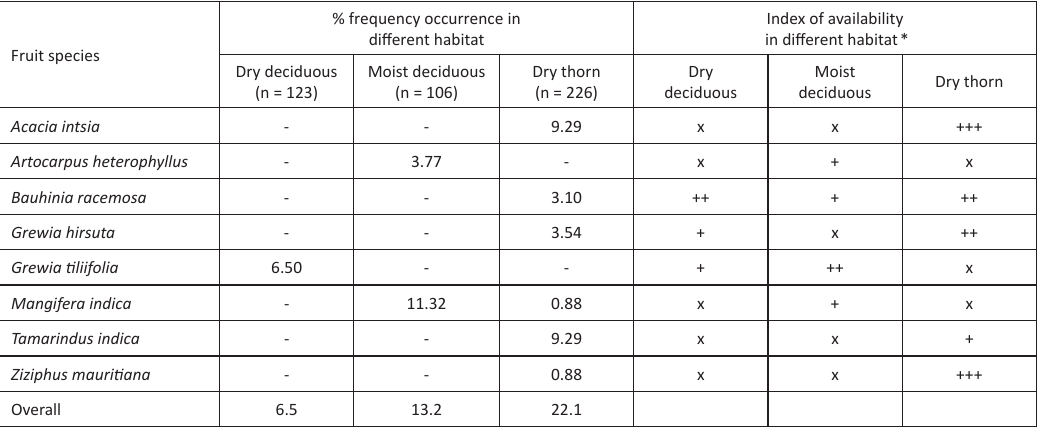
Table 2. Percent frequency occurrence of various species of fruits appeared with respect to the total number of elephant dung piles sampled in different habitats and the index of availability of those fruit species in different habitats of Nilgiri Biosphere Reserve, southern India. % frequency occurrence in different Fruit species